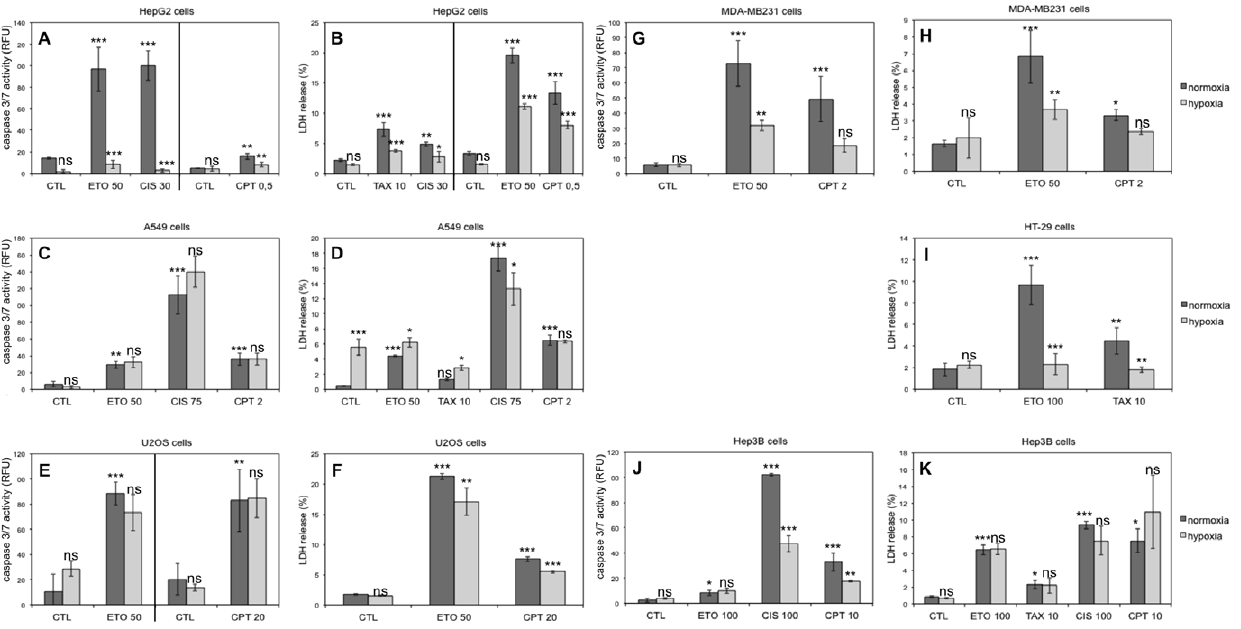
Figure 1. Effect of hypoxia on chemotherapeutic agents-induced cell death. HepG2, A549, U2OS, MDA-MB231, HT-29, Hep3B and PC-3 cells were incubated under normoxia (21% O 2 ) or hypoxia (1% O 2 ) in the absence (CTL) or presence of etoposide (ETO), paclitaxel (TAX), cisplatin (CIS) or camptothecin (CPT) for 16 (A, C, E, G, J) or 40 hours (B, D, F, H, I, K). The concentration used for each molecule is indicated in the graphs (in m M). (A, C, E, G, J) Caspase-3/7 activity was assayed by measuring the fluorescence of free AFC released from the cleavage of the caspase-3/7 specific substrate Ac-DEVD-AFC. Results are expressed in relative fluorescent units (RFU) as means 6 1 SD (n =3). (B, D, F, H, I, K) LDH release was assessed. Results are presented in percentages as means 6 1 SD (n =3). (A-K) Statistical analysis was carried out with ANOVA 1. ns: non-significant; *: P , 0.05; **: P , 0.01; ***: P , 0.001. Symbols above a normoxic column are a comparison with the normoxic control and symbols above a hypoxic column are a comparison with the corresponding normoxic condition (with the same drug).